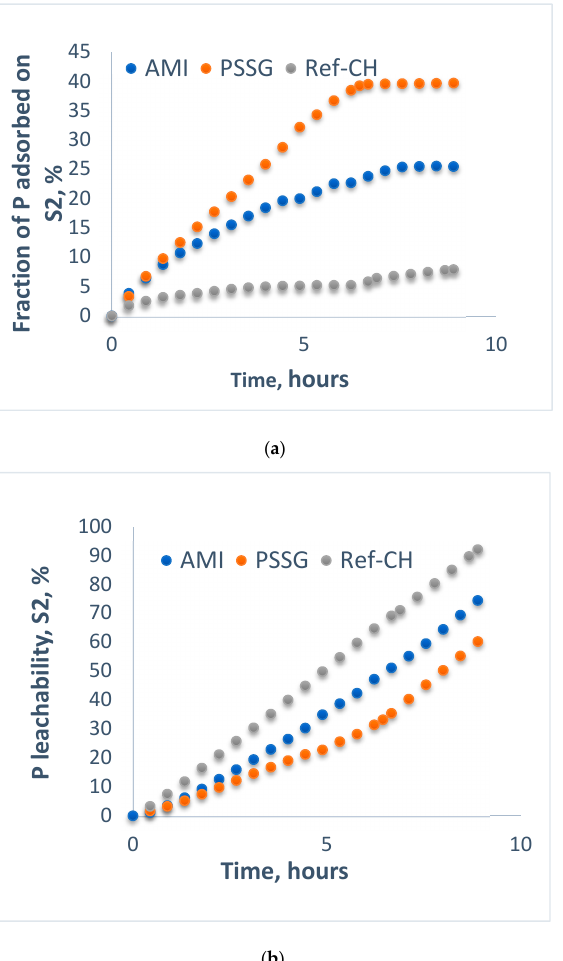
Figure 4. Fractions of phosphorus adsorbed ( a ) and leached ( b ) for the fertilizers on the mixture of sand and soil S2 ‐ CL.